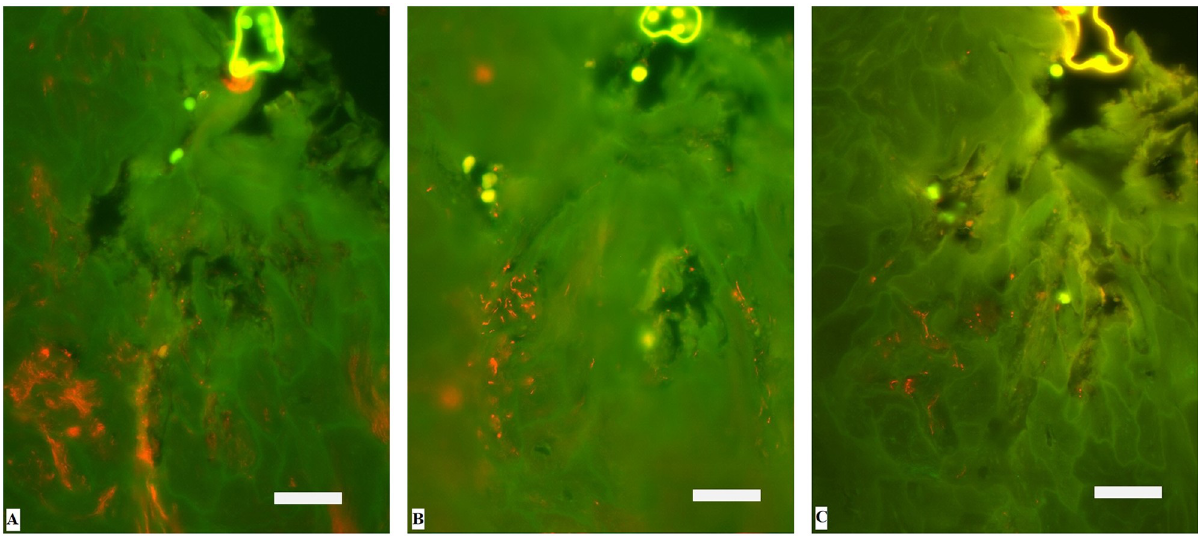
Fig 4. Identification of Treponema organisms infiltrating the interdigital skin of European bison ( Bison bonasus ) with digital dermatitis by fluorescent in situ hybridization. Three serial sections of the biopsy from the left hind foot of animal no. 5 hybridized with (Cy3 labelled) species specific oligonucleotide probes for A: Treponema phagedenis , B: Phylotype 13 (PT13), and C: Phylotype 3 (PT3), respectively. The Treponema organisms appear orange. Bar 25 μ m.